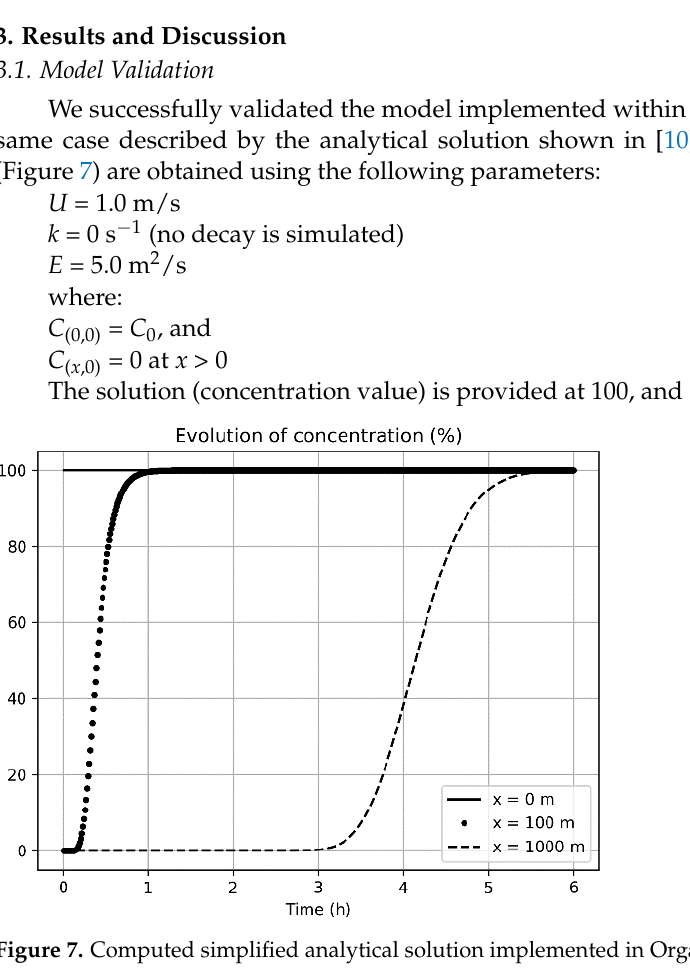
Figure 6. Example graph: solution at a selected time as function of distance from the inlet point.